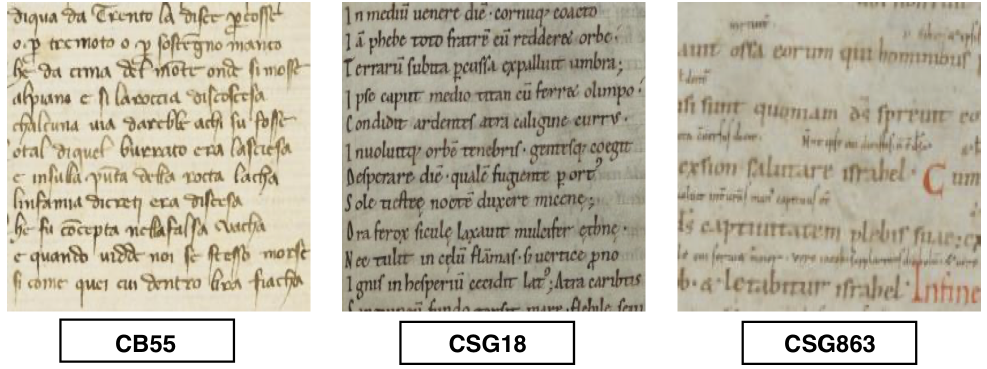
Figure 7. VML-AHTE dataset includes four ground truth formats: PAGE xml, pixel labels, DIVA pixel labels, and bounding polygons.